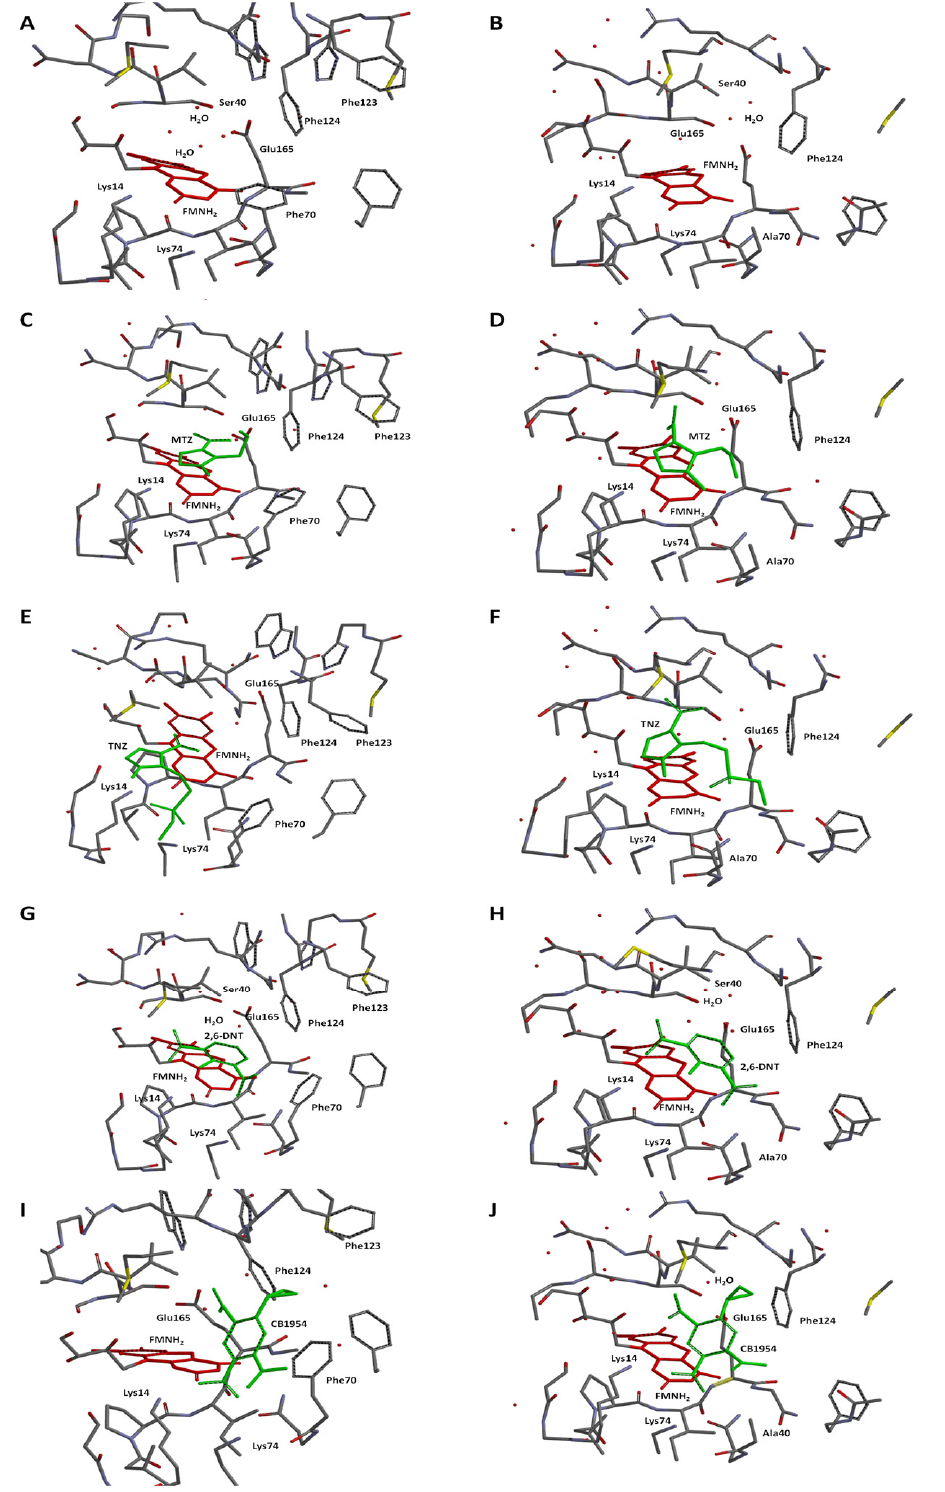
Figure 8. Optimised structures of the active center fragments of V. vulnificus NfsB (Left panels; ( A , C , E , G , I ) and NTR 2.0 (Right panels), ( B , D , F , H , J ) without ( A , B ) or with ( C – J ) bound substrates. Substrates: metronidazole (MTZ; ( C , D )); tinidazole (TNZ; ( E , F )); 2,6-dinitrotoluene (2,6-DNT; ( G , H )); and CB1954 ( I , J ). The isoalloxazine ring of FMNH 2 is marked in red, nitroaromatic substrates marked in green, water molecules marked by red dots. Hydrogen atoms were removed for clarity.